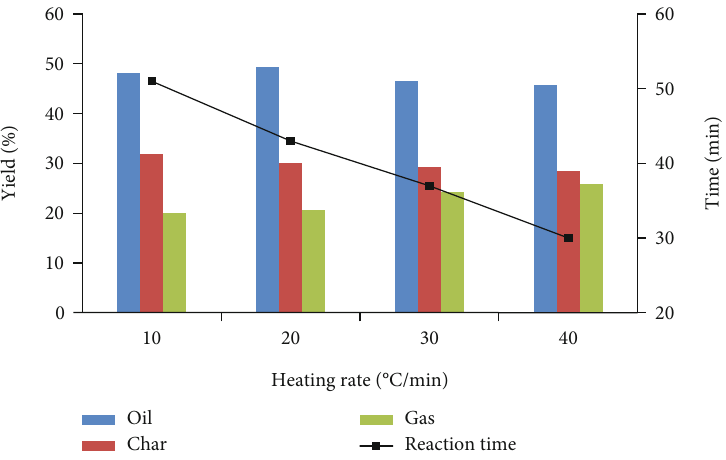
Figure 4: E ff ect of heating rate on yields of NOC thermal